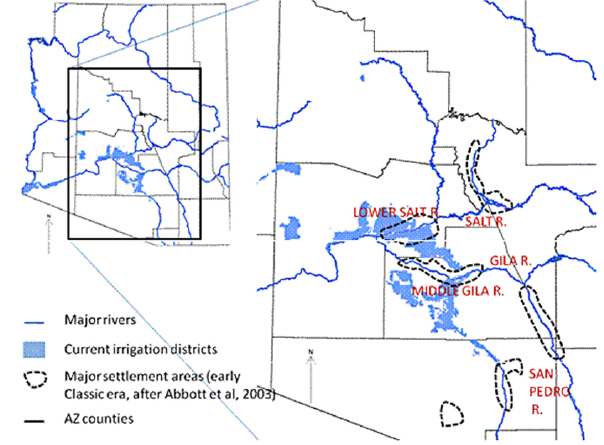
Fig. 9. The evolution of population density in terms of settlement area (after Madella and Fuller, 2006). Also shown are the various eras: Localization refers to Late Harappan Era, Integration refers to the Mature Harappan, Regionalization refers to the transition from the early Food Producing Era to the Early Harappan Era. The dashed line represents the carrying capacity of the basin, adapted from the modeling results of Vahia and Yadav (2011), which also shows that the transitions between the shown era was also comple- mented by technological innovations.